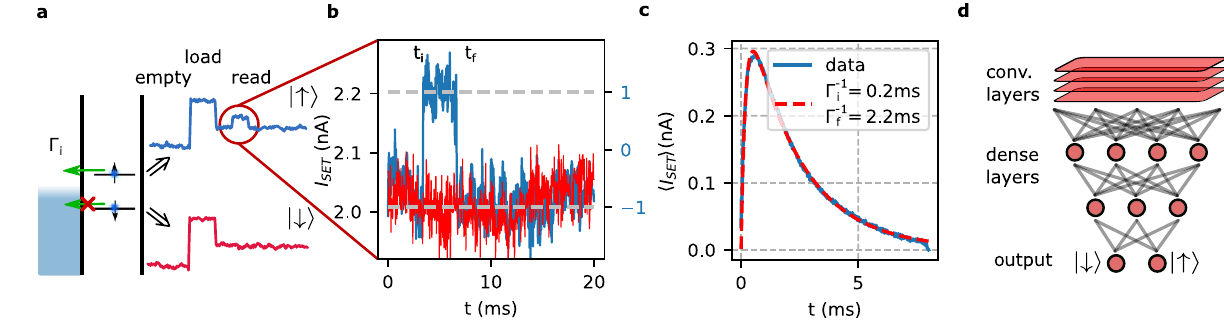
Figure 1. Single-shot measurement traces and architecture of the neural network. ( a ) Sketch of the Zeeman energy-resolved tunneling from the QD to the reservoir with a tunnel rate Ŵ i . Two typical SET current traces showing the cycle of emptying and loading stage of the QD followed by the qubit readout stage are also shown. Only when the qubit state is |↑� -spin, the electron tunnels out of the QD at time t i and a |↓� -spin tunnels on the QD at time t f resulting in a peak in the SET current (blue trace). ( b ) Zoom-in of two measured SET current traces spanning the readout stage. The blue and red traces are classified to be |↑� and |↓� , respectively. ( c ) Current signal spanning the readout stage averaged for many |↓� and |↑� traces (blue), fitted by Eq. (1) (dashed red line). ( d ) Architecture of the network used to classify peak traces. One trace spanning the readout time is used as input (top) and classification is output by two neurons (bottom), giving the probability of |↓� and |↑�